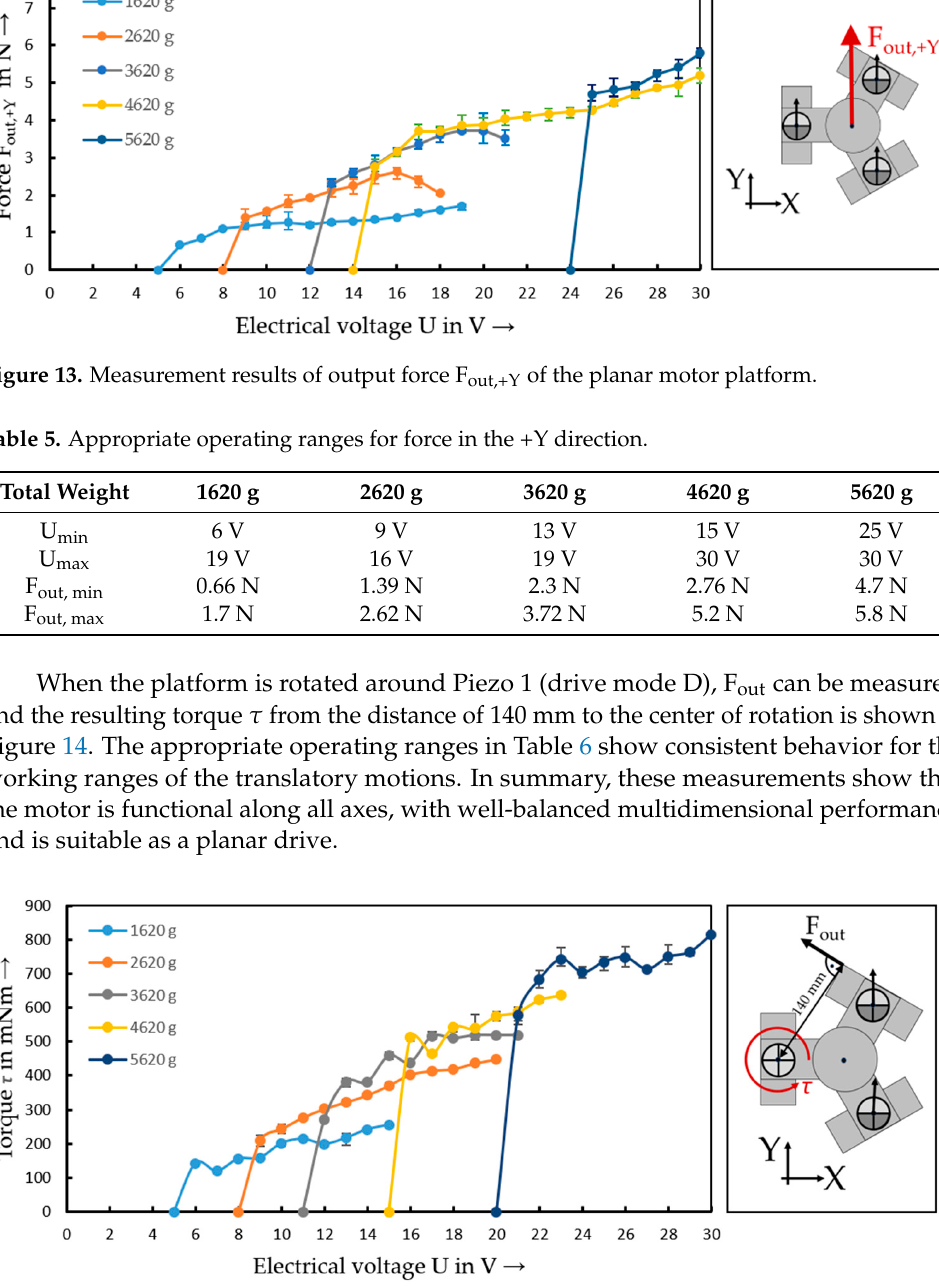
Table 6. Appropriate operating ranges for rotation around Piezo 1.